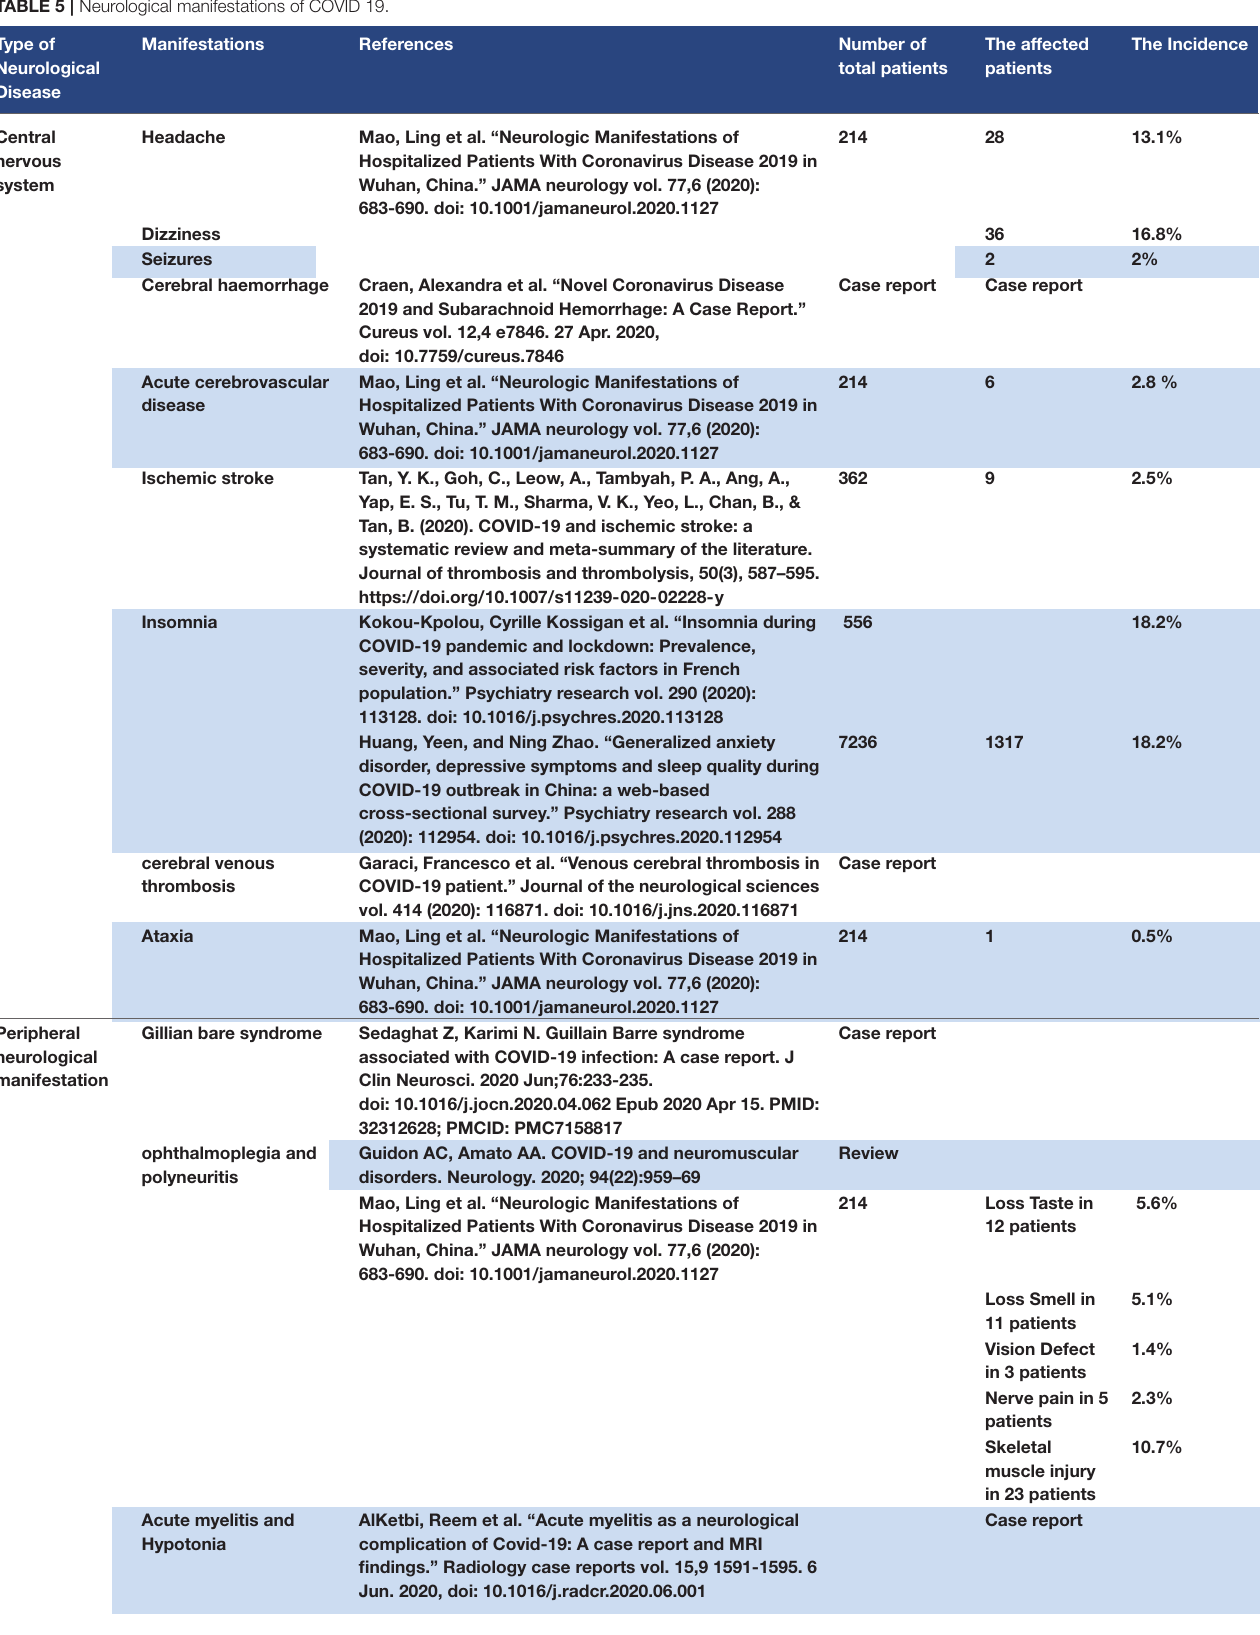
TABLE 5 | Neurological manifestations of COVID